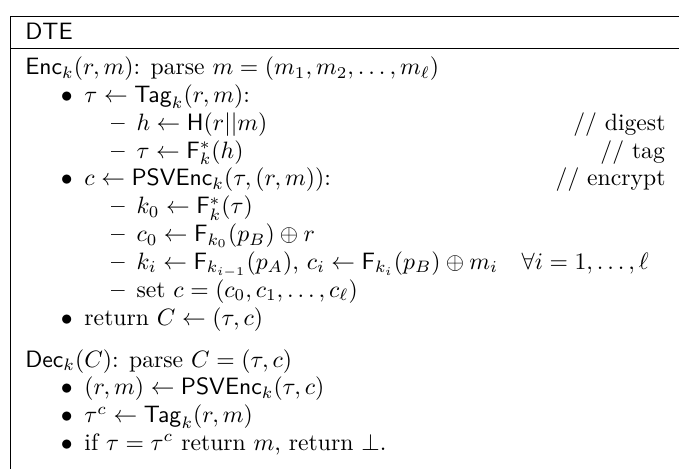
Figure 2: DTE leakage-resilient authenticated encryption (part II). Table 1: DTE leakage-resilient authenticated